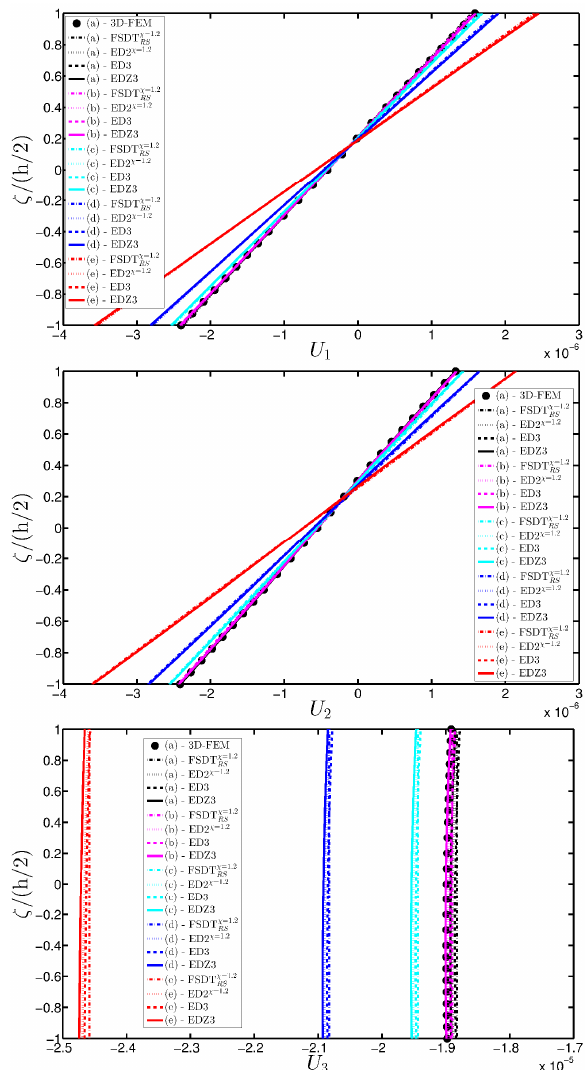
Figure 16. Through-the-thickness profiles of displacement components [m] for the CCCC laminated square plate with ( − 45/0/45 ) as stacking sequence computed at the point A for different HSDTs. The effect of the damage is investigated by varying the parameters of the function Gau-4.